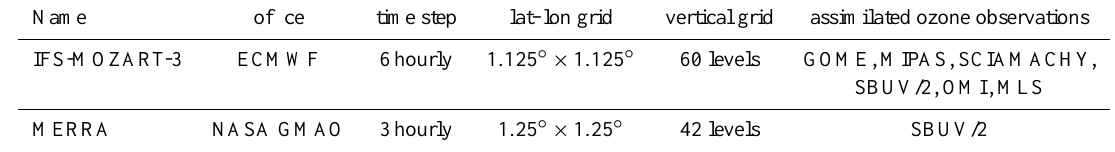
Table 2. Characteristics of the two reanalyses from which atmospheric ozone fields were used as input to metrology